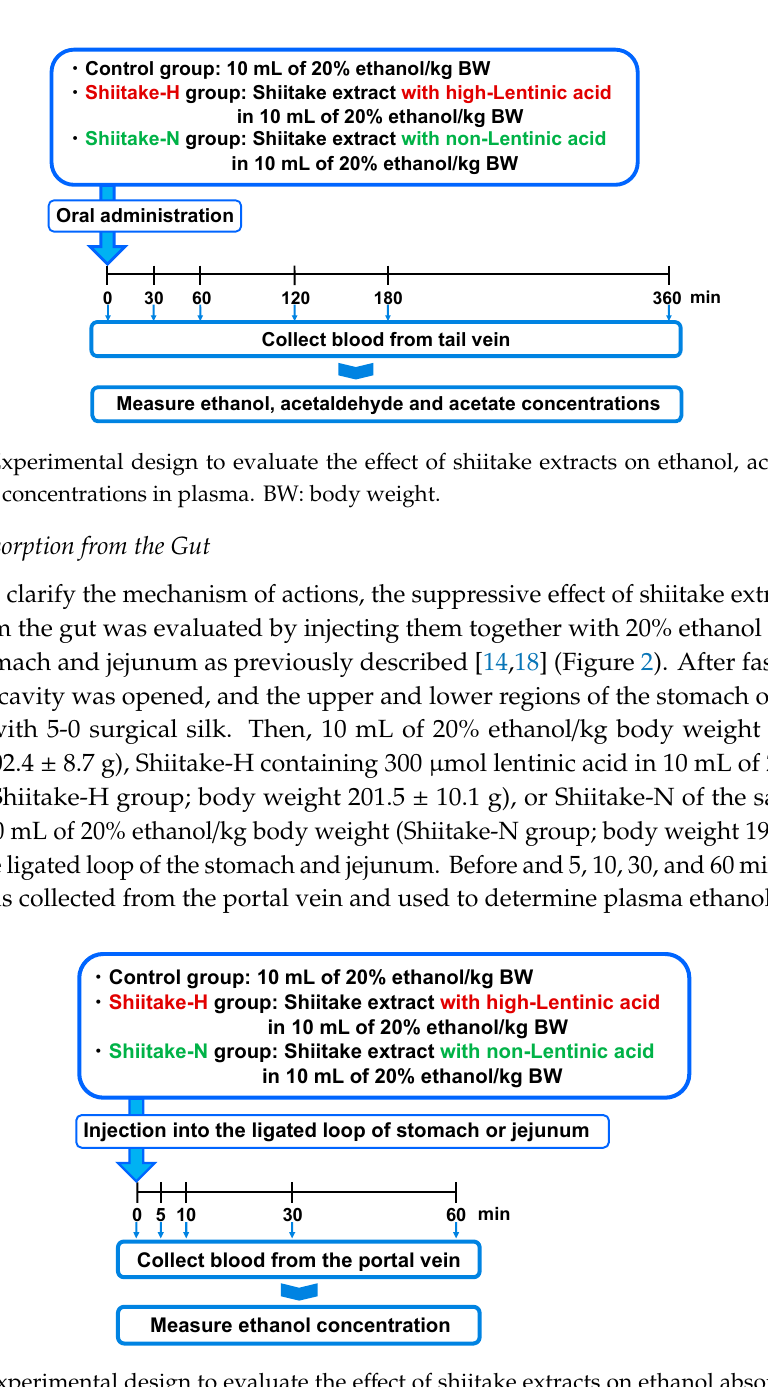
Figure 2. Experimental design to evaluate the effect of shiitake extracts on ethanol absorption from the gut.